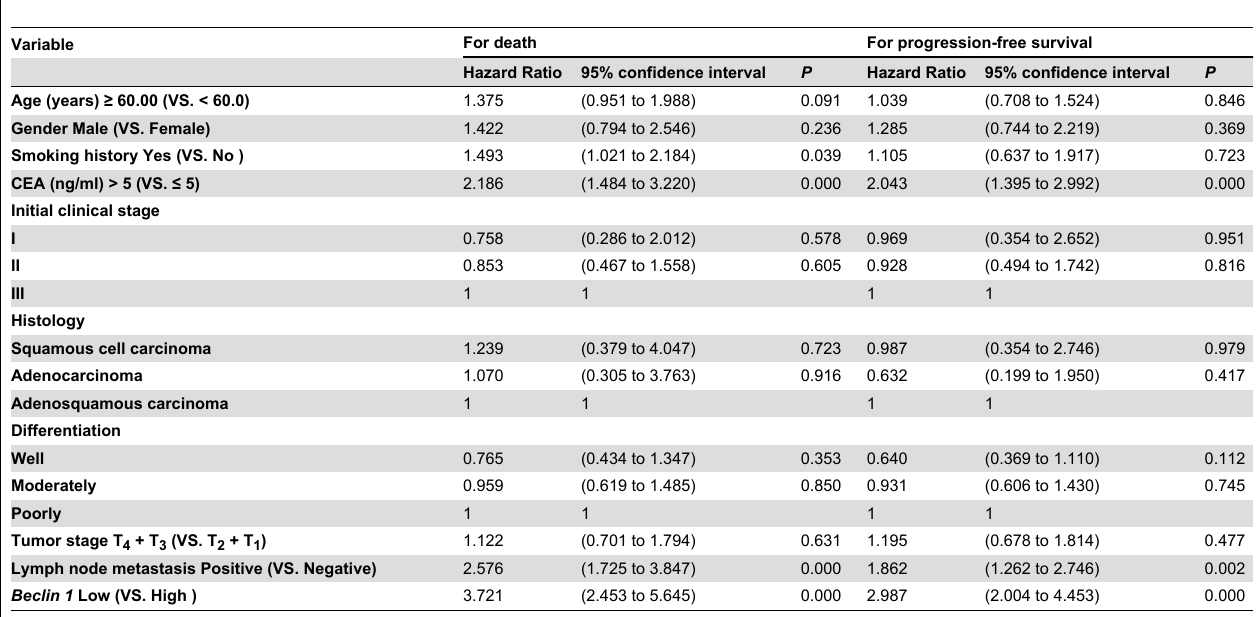
Table 3. Results of multivariate Cox proportional-hazards analysis in the overall patient cohort (n = 216).